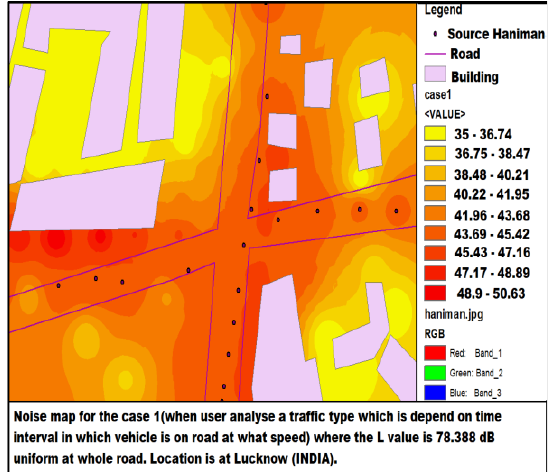
Figure 16. Noise strength for case 1 scenario